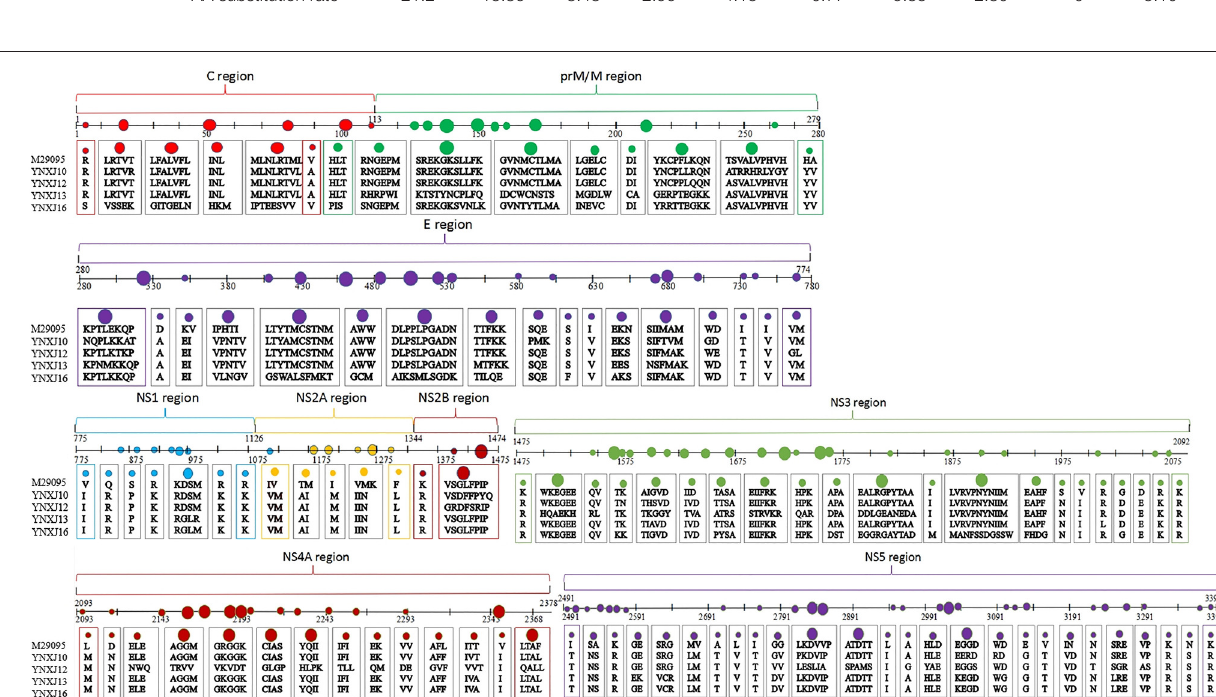
FIGURE 2 | Amino acid substitutions in YNXJ10, YNXJ12, YNXJ13, and YNXJ16 compared to the DEN2SS M29095. The first line is M29095, and the second to fifth lines are YNXJ10, YNXJ12, YNXJ13, and YNXJ16, respectively. The labeled numbers represent the amino acid position.